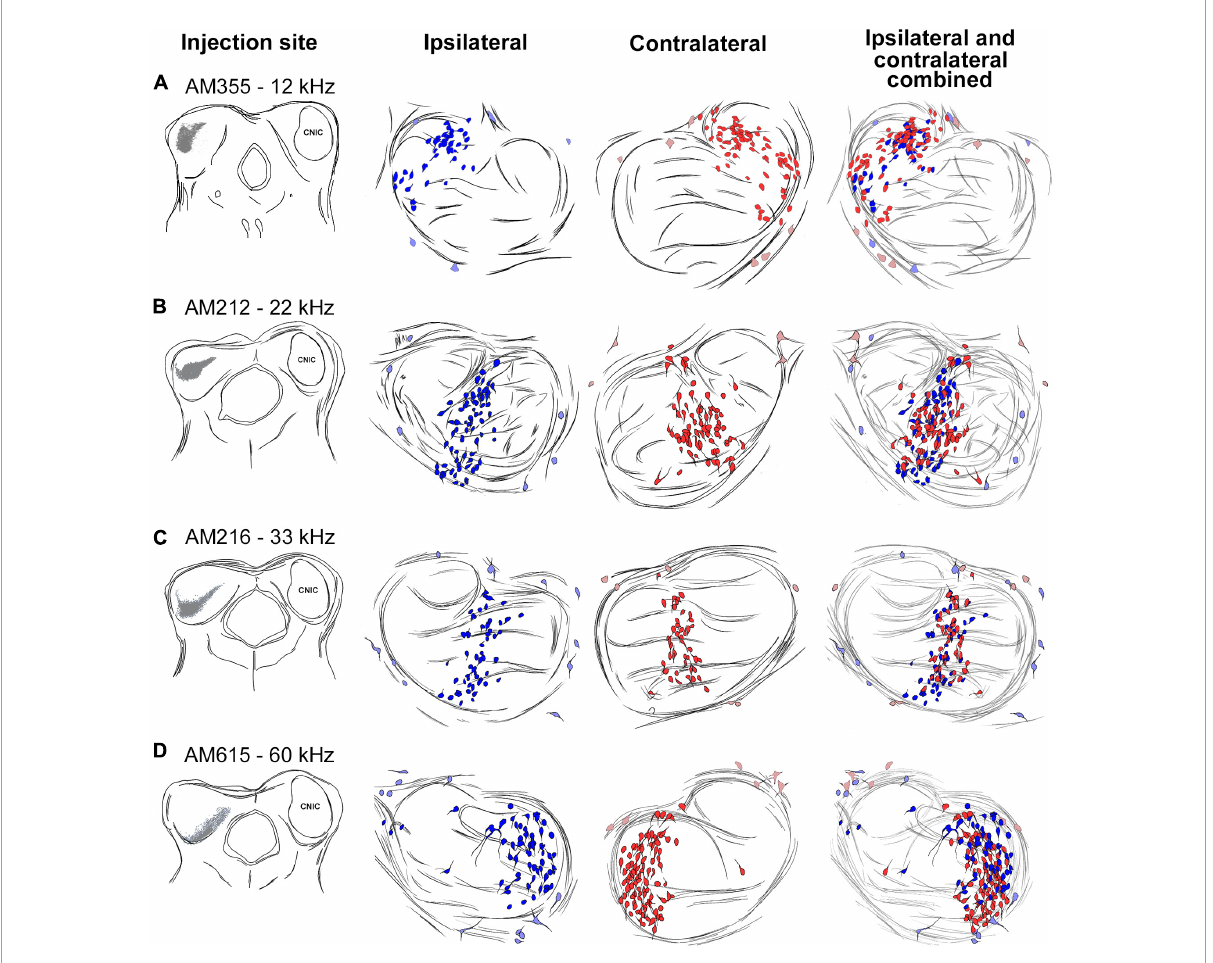
FIGURE5 Topographic relationship between the IC and the LSO. Tracing of IC injection sites progressing more ventral and higher in frequency [ (A–D) , left column]. The corresponding bilateral labeling of LSO principal cells (ipsilateral-dark blue, contralateral-dark red, middle two columns) and periolivary (PO) cells (ipsilateral-light blue, contralateral-light red) were traced through serial sections, aligned using blood vessels, and merged. The ipsilateral and contralateral labeling for each injection was combined (last row) to show the bilateral preservation of topographic and tonotopic organization of principal cells across the LSO. PO cells do not observe a tonotopic distribution (light blue and red). kHz,